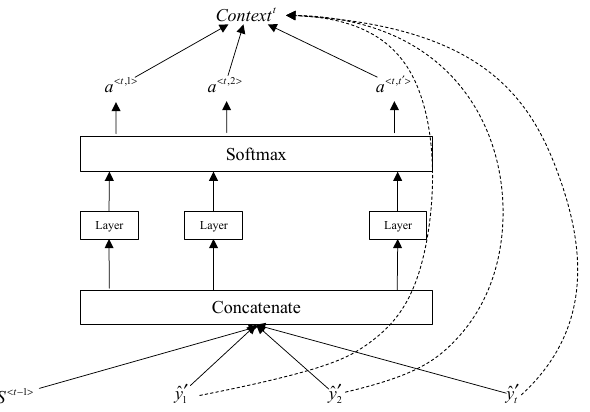
Figure 3. Attention mechanism. Figure 3. Attention